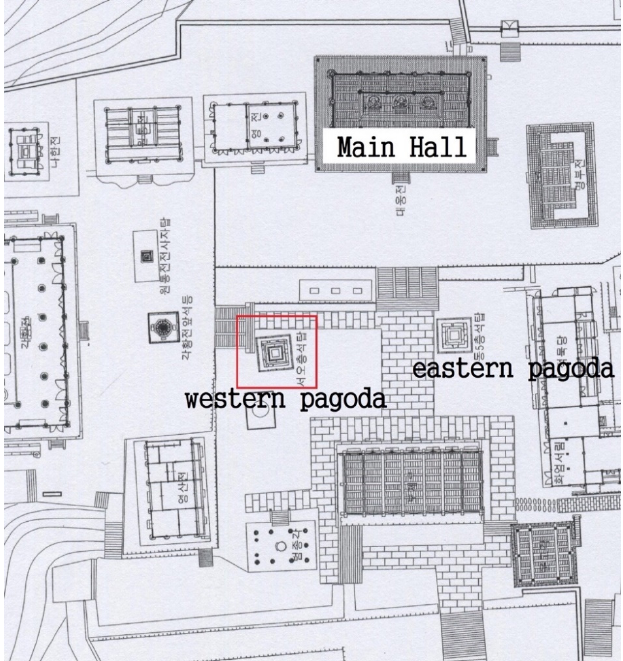
Figure 5. Floor plan of the two pagodas of Hwa ŏ m temple, square mark western stone pagoda [©Cultural Heritage Administration in Korea].